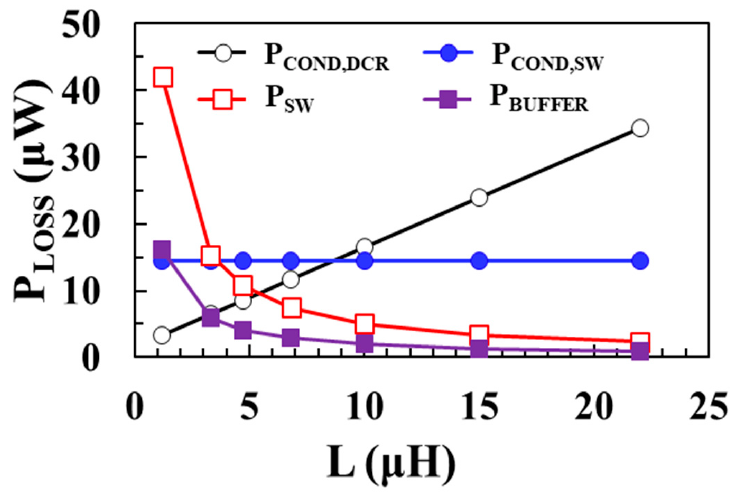
Figure 4. Modeling results of each loss component according to inductance.